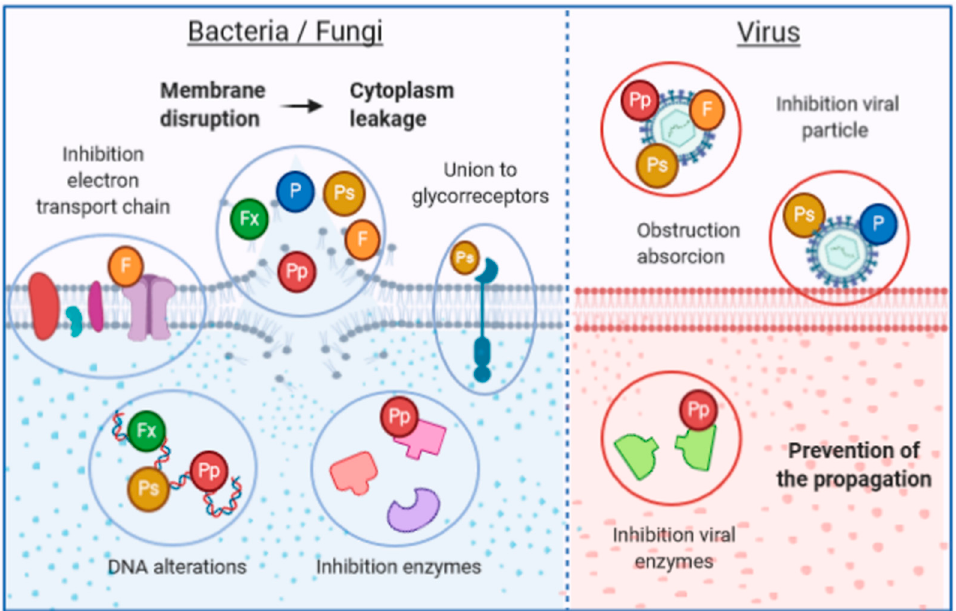
Figure 2. Schematic illustration of the main action mechanisms of antimicrobial compounds extracted from macroalgae species.